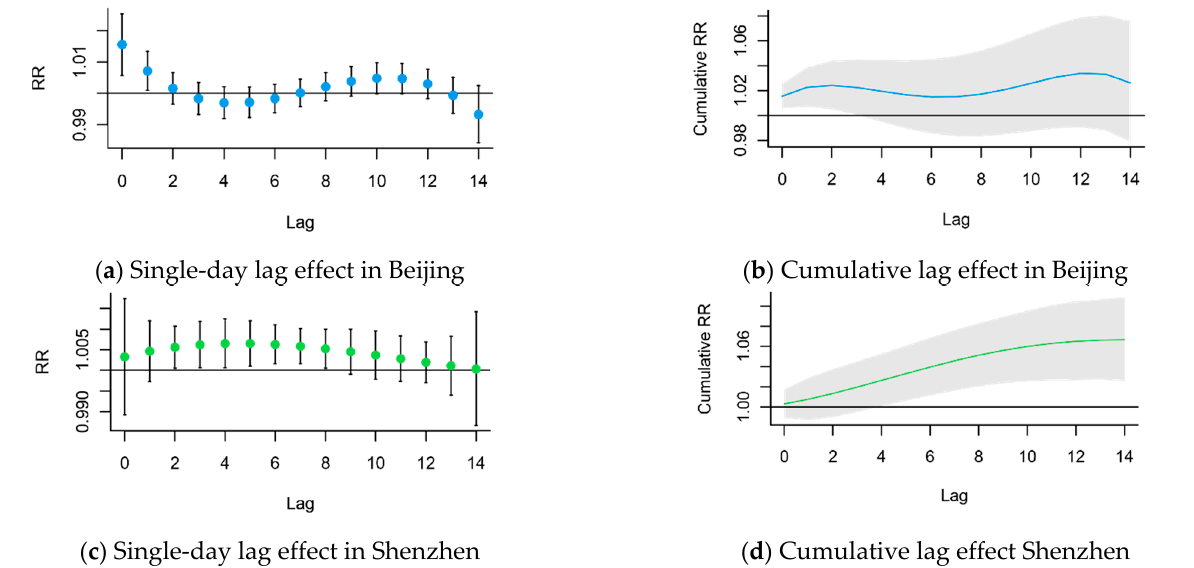
Figure 3. Exposure-response relationship between PM 2.5 and RR of AECOPD in ( a ) single-day lag effect in Beijing, ( b ) cumulative lag effect in Beijing, ( c ) single-day lag effect in Shenzhen and ( d ) cumulative lag effect in Shenzhen.